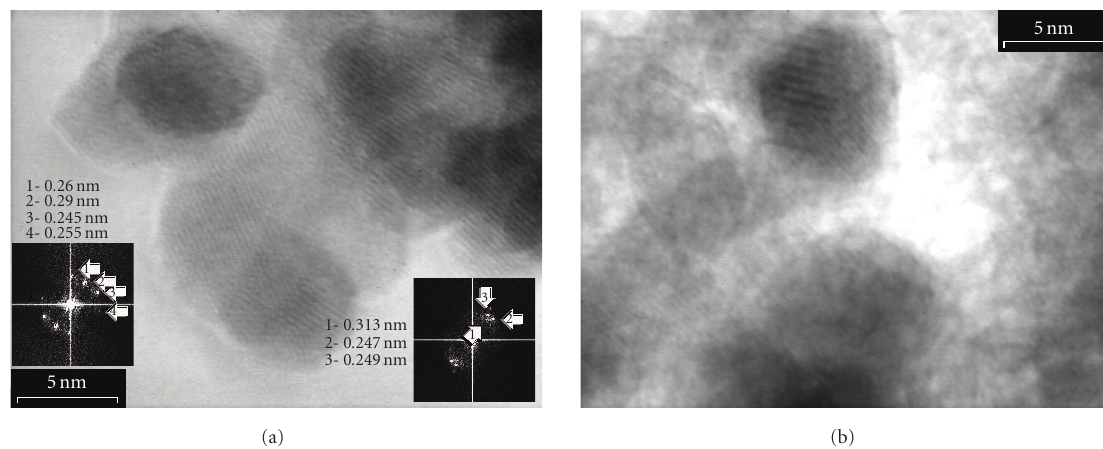
Figure 5: HRTEM images for samples: (a) 01 and (b) 02. Space representations of Fourier transform (displayed as insets on figure) seem to evidence the di ff raction planes of maghemite/magnetite.